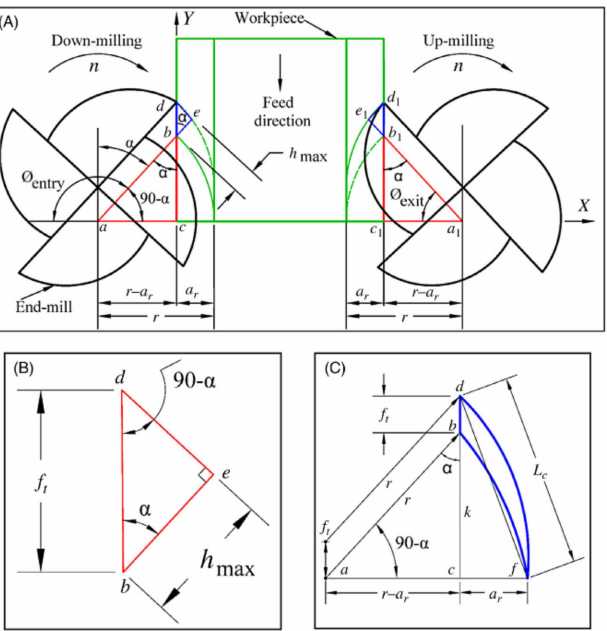
Figure 9. Chip formation showing ( A ) chip formation showing cutter tooth entry angle in down- milling and cutter tooth exit angle in up-milling, ( B ) maximum chip thickness, h max , and ( C ) chip length, L c